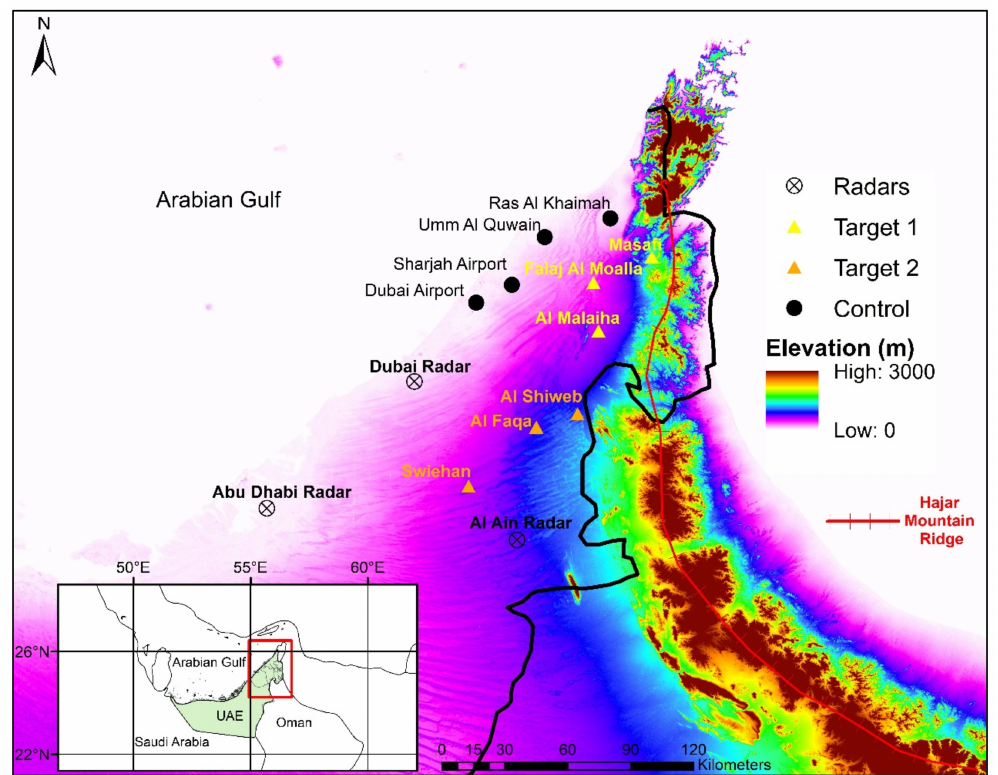
Figure 1. Location and terrain elevation of the study area in the northeastern UAE and the distribution of target/control rain gauges and polarimetric weather radars.